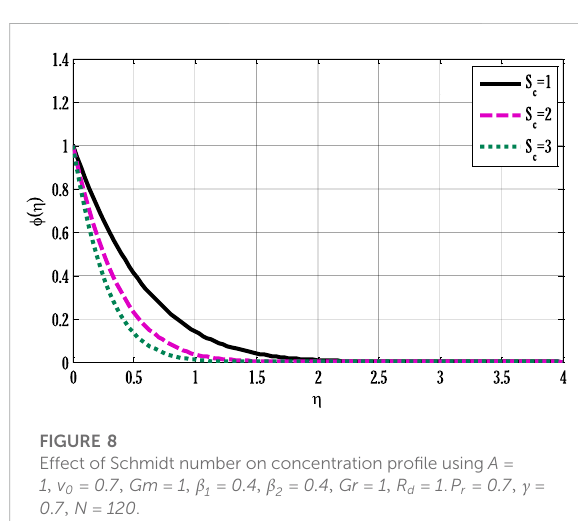
FIGURE 5 Effect of non-linear solutal convection parameter on velocity pro fi le using A (cid:1) 1 , v 0 (cid:1) 0 . 7 , Gm (cid:1) 1 , β 1 (cid:1) 0 . 4 , Gr (cid:1) 1 , P r (cid:1) 0 . 7 , R d (cid:1) 1 . S c (cid:1) 0 . 9 , γ (cid:1) 0 . 7 , N (cid:1) 120 .